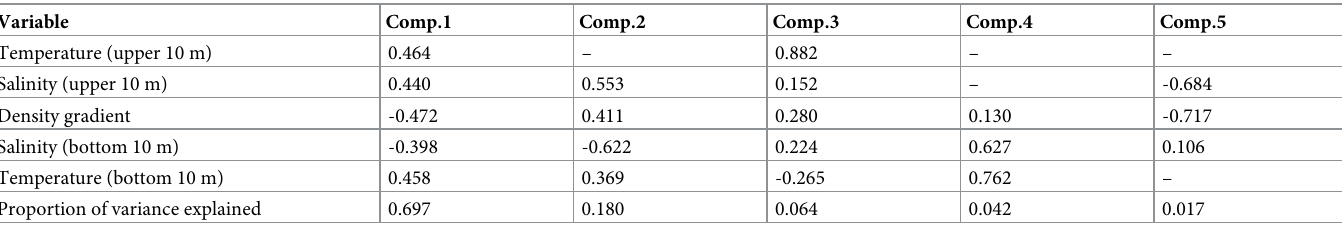
Table 3. Factor loading output from principal component analysis of 5 oceanographic variables calculated over survey transects within hexagon shaped grid cells. Variable Comp.1 Comp.2 Comp.3 Comp.4